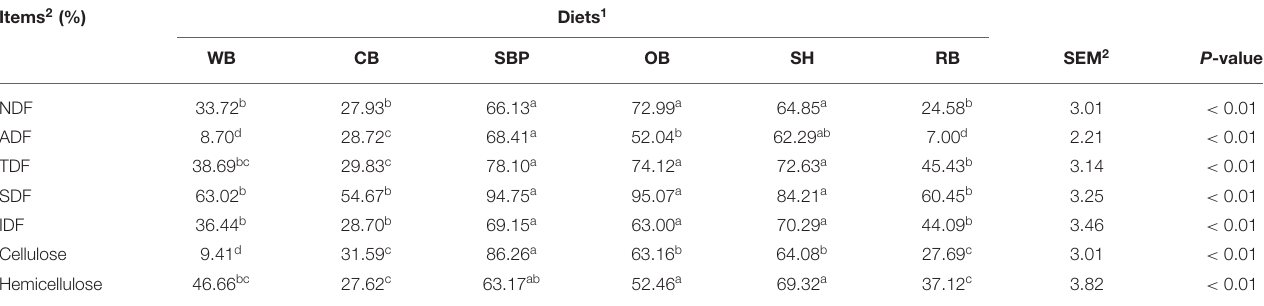
TABLE 4 | Determined apparent hindgut fiber fermentability for ileal cannulated pigs fed the diets with different sources of fiber ( n = 6 per group). Items 2